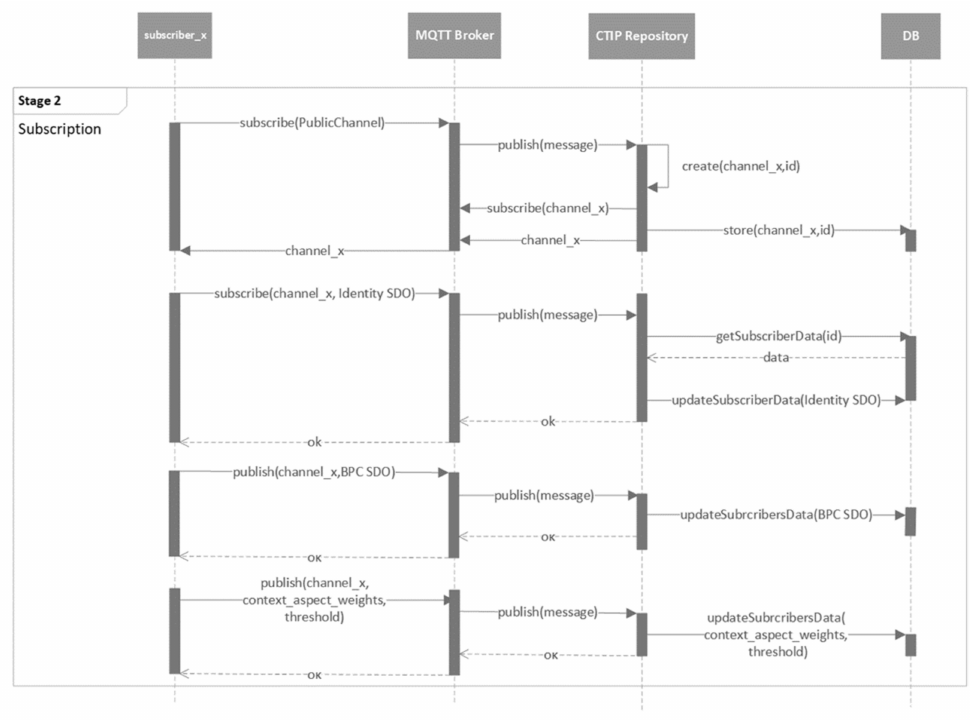
Figure 11. UML behavioral diagram of the organizations’ subscription stage (stage